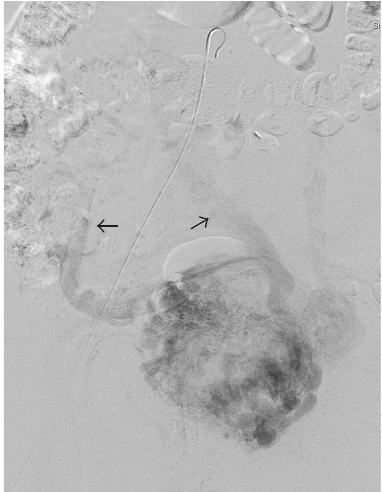
Figure 5: Pelvic angiogram—late venous phase. Early venous drain- age to internal iliac veins (arrowed).